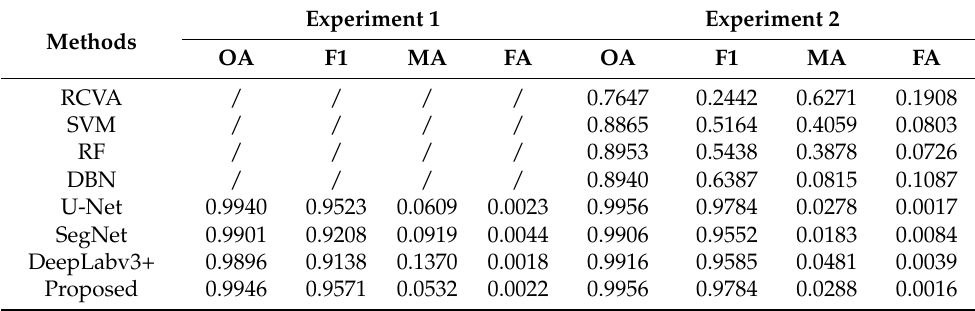
Table 7. Accuracy assessment on 3D change detection